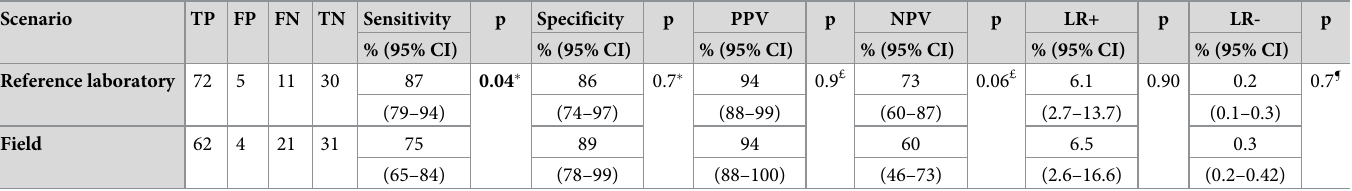
Table 3. Diagnostic performance of RPA-LF in reference laboratory and field scenarios compared with composite gold standard (n = 118). Scenario